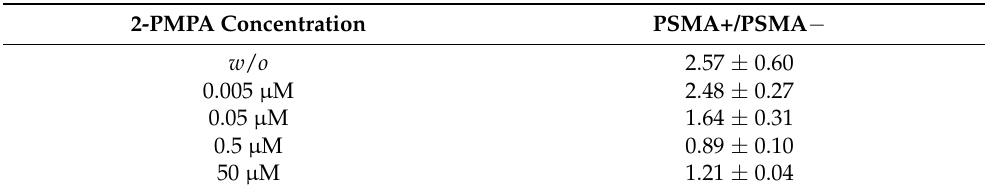
Table 1. PSMA+/PSMA − ratios of activity concentrations for the respective 2-PMPA concentration. The values are given as the average of the ratios and the respective